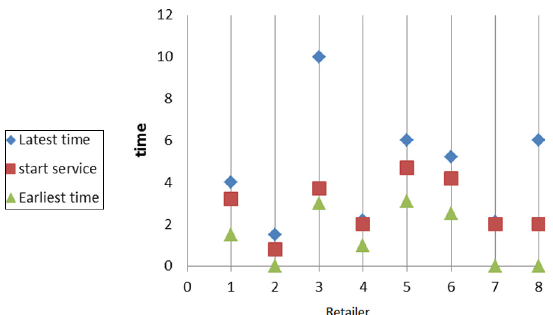
Figure 5. Compliance check for soft time windows